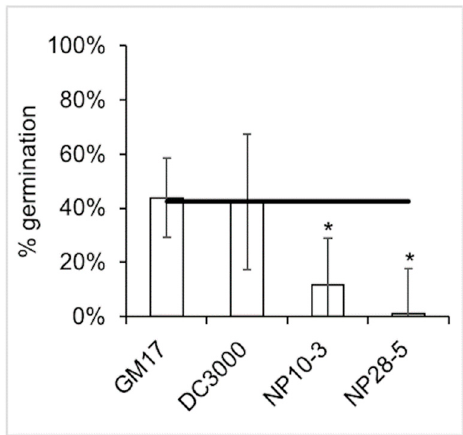
Figure 2. Germination efficiency of P. trichocarpa seeds treated with bacterial cultures. Horizontal line, control germination efficiency of seeds treated with sterile bacterial growth media. Error bars, standard deviation of three biological replicates of 50–100 seeds per treatment condition. *, p < 0.05.